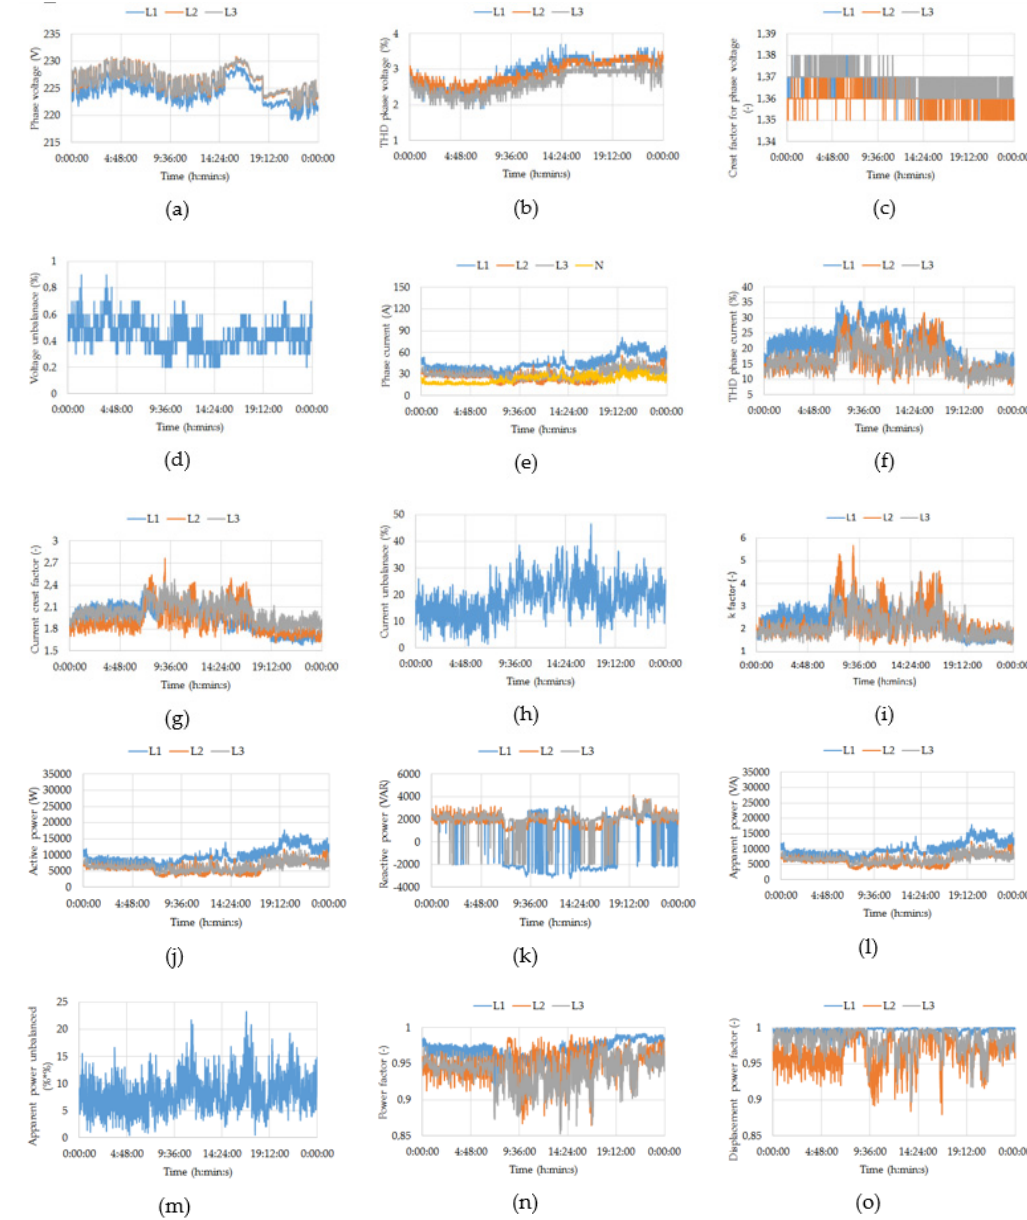
Figure 25. Recordings of some electrical measurement from power substation of residential and educational area on a weekend day: ( a ) Phase voltages; ( b ) THD for phase voltages; ( c ) Crest factor for voltages; ( d ) Voltage unbalance; ( e ) Phase currents; ( f ) THD for phase currents; ( g ) Crest factor for currents; ( h ) Current unbalance; ( i ) K -factor; ( j ) Active power; ( k ) Reactive power; ( l ) Apparent power; ( m ) Apparent power unbalance; ( n ) Power factor; ( o ) Displacement power factor (for fundamental harmonics).